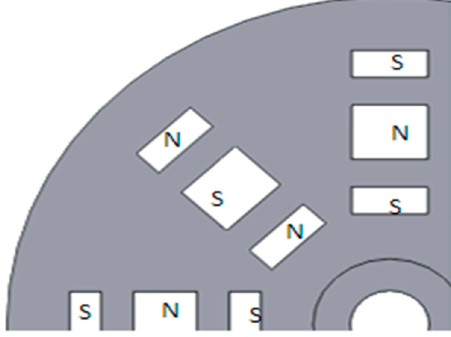
Figure 2. The way permanent magnets are placed over the disk of rotor.